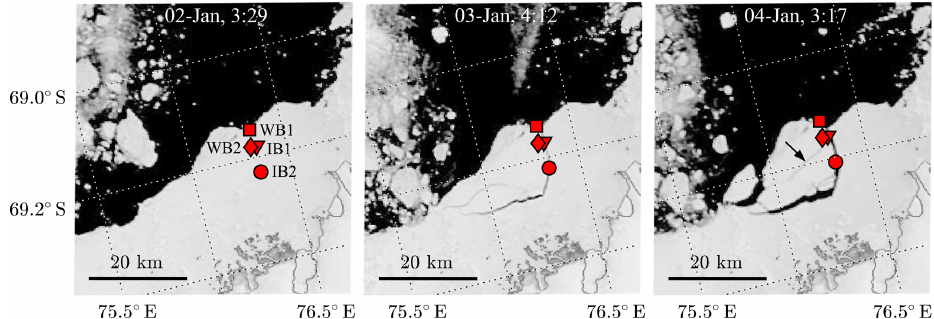
Figure 3. MODIS imagery (https://worldview.earthdata.nasa.gov/, last access: 12 March 2020) of the Antarctic deployment site on 3 consec- utive cloud-free days during the initial sea ice break-up. Instruments are indicated by markers: WB1 (square), WB2 (diamond), IB1 (triangle) and IB2 (circle). Note that the marker of IB1 is shifted here for visualization purposes and that IB1 was originally deployed 40m from WB2.